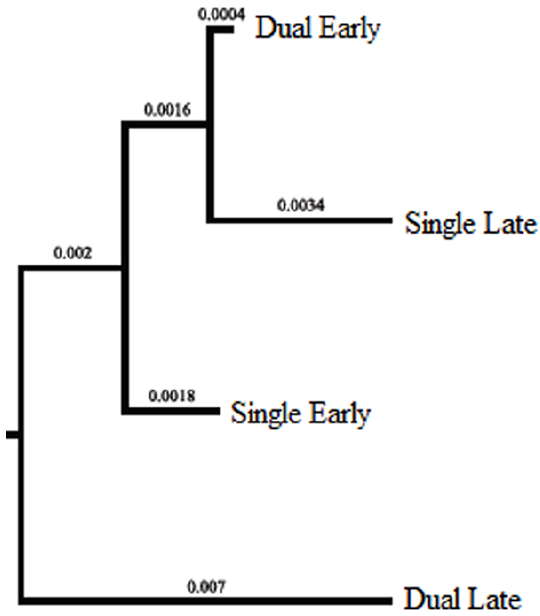
Figure 2. Clustering of FIVC from dual and single infections. F tree showing the relationships among the temporally-spaced infection groups. Branch lengths are shown at the base of the respective nodes.